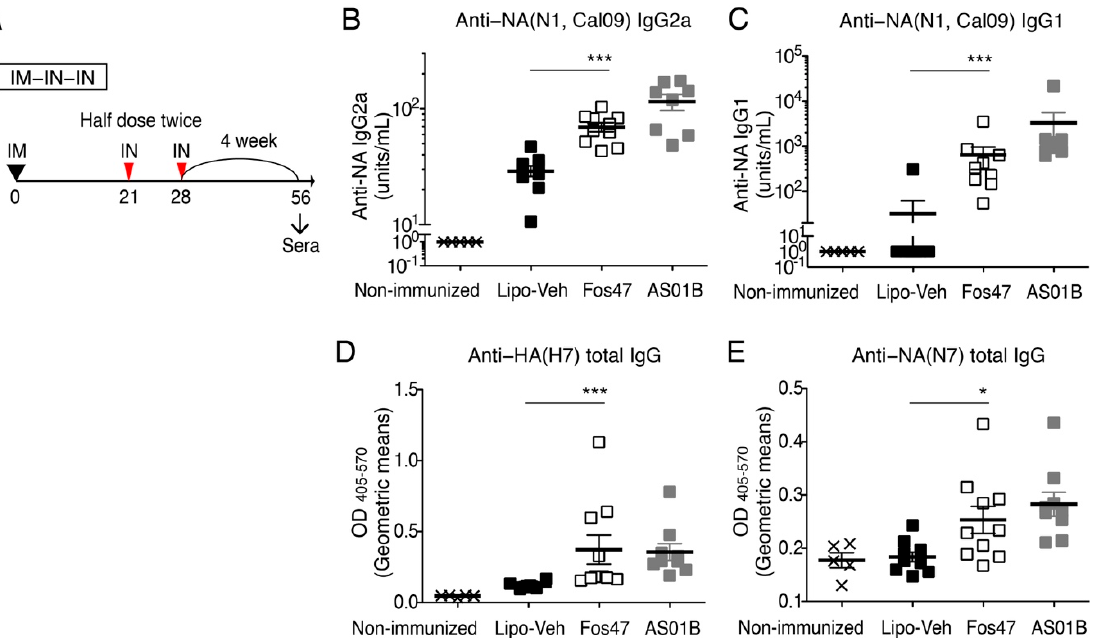
Figure 5. IM-IN-IN combination regimen with Fos47 enhanced serum IgG responses against NA and phylogenetically distinct virus strains. Female BALB/c mice ( n = 5–10/group) were IM primed with IIAV plus Lipo-Veh, Fos47 or AS01B. The mice were IN boosted with a half dose of the same agents on days 21 and 28 (IM-IN-IN). Sera were collected on day 56. ( A ) Experimental protocol. IgG2a ( B ) and IgG1 ( C ) specific to NA [A/California/04/2009 (H1N1), homologous strain] were evaluated by ELISA. Units/mL (arbitrary units) are presented. ( D , E ) Total IgG cross-reactive to H7 ( D ) and N7 proteins ( E ) of A/Netherlands/219/2003(H7N7) were measured by ELISA. Phylogenetic relationships of HA and NA proteins are depicted in Figure 2A (for HA) and Figure S3 (for NA). Geometric means of OD are presented. Bars indicate means ± SEM. * p < 0.05, *** p < 0.001, two-tailed Mann–Whitney U -test to compare IN-Lipo-Veh and Fos47.